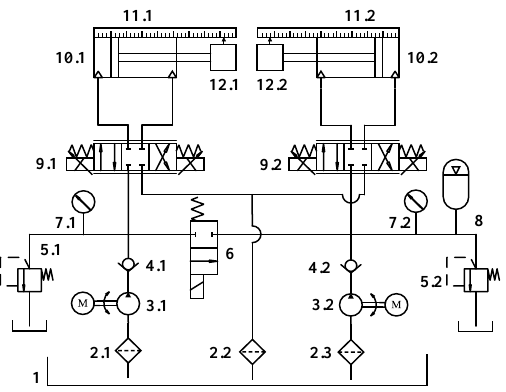
Figure 1. Hydraulic schematic of the experimental platform. (1) Tank. (2) Filter. (3) AC motor and pump. (4) Check valve. (5) Relief valve. (6) Two-position two-way directional valve. (7) Pressure gauge. (8) Accumulator. (9) Proportional directional valve. (10) Hydraulic cylinder. (11) Linear displacement sensor. (12) Inertia load.